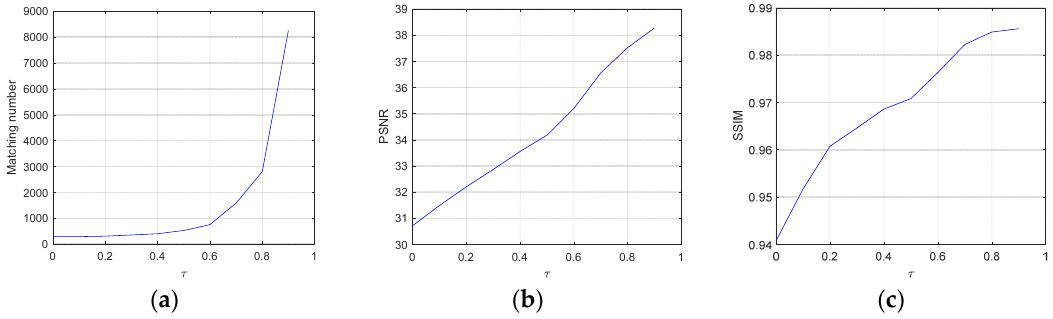
Figure 6. The effects of the threshold for BMS: ( a ) Matching number; ( b ) PSNR; ( c ) SSIM.